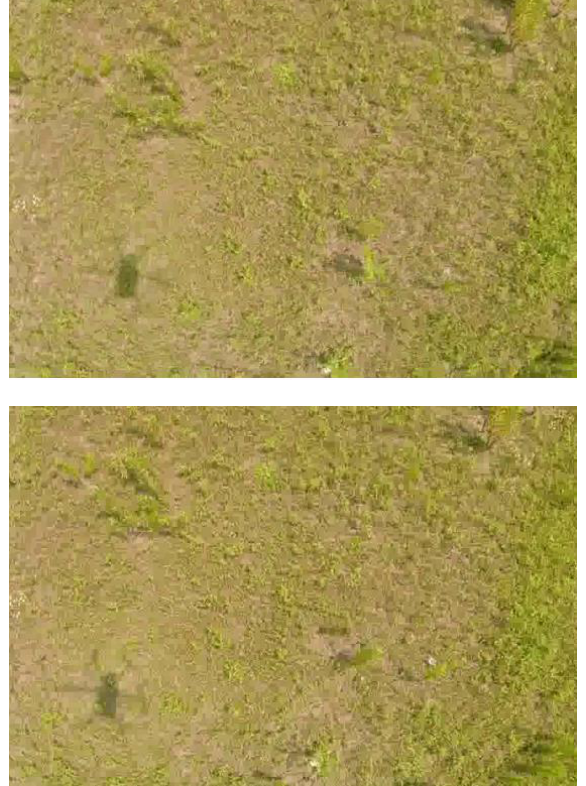
Figure 7. Motion of vegetation